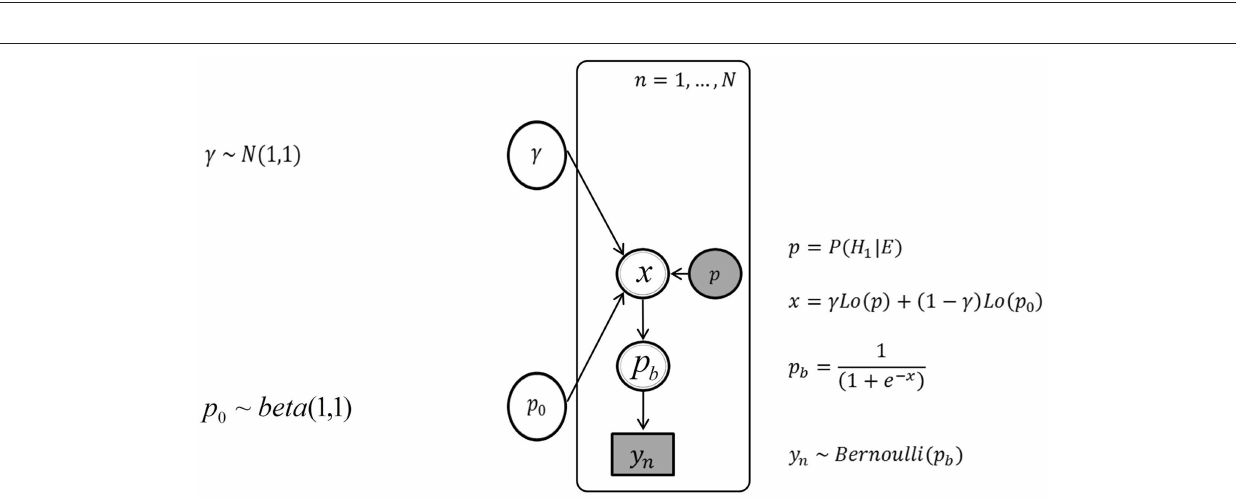
FIGURE 4 | The graph of the Bayesian network without inter-individual differences, with the urn inference y n , the posterior probability p , and the parameters p 0 and γ